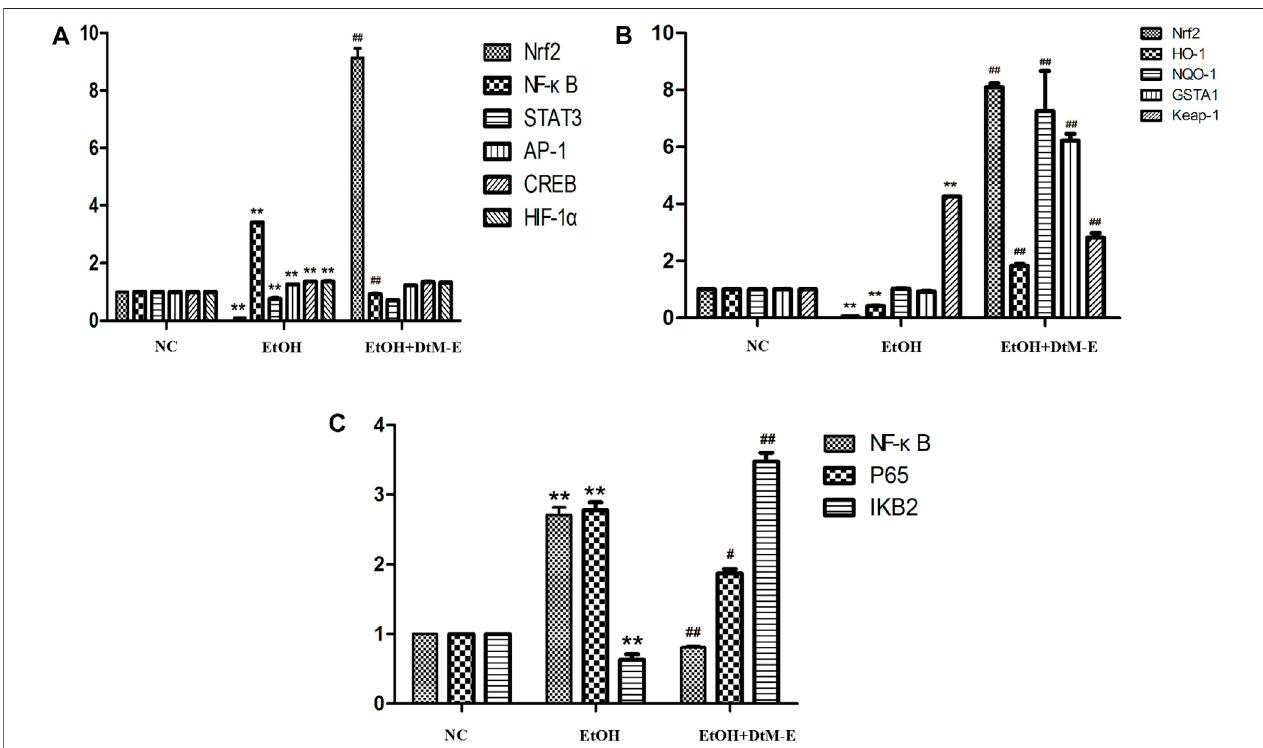
FIGURE 4 | Effects of DtM-E on nuclear transcription factors of Nrf2, NF- κ B, STAT3, AP-1, CREB, and HIF-1 α (A) , the signaling pathways of Nrf2/HO-1 (B) , and P65/NF- κ B (C) . All data are presented as mean ± SD ( n = 6). ** p < 0.01 ( vs . control group); p < 0.01 ( vs . model group).